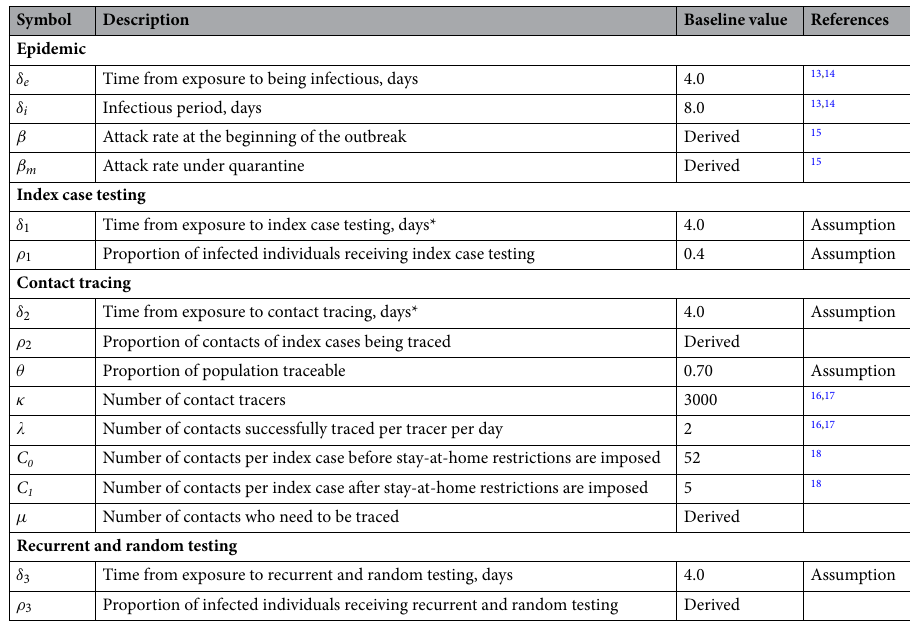
Table 1. Key parameters for the SEIQ-R model with concurrent testing, tracing, and quarantine and disease progression in NYC. *This assumes that index cases and contacts will be isolated or quarantined upon receiving the diagnostic and/or laboratory test, whichever comes